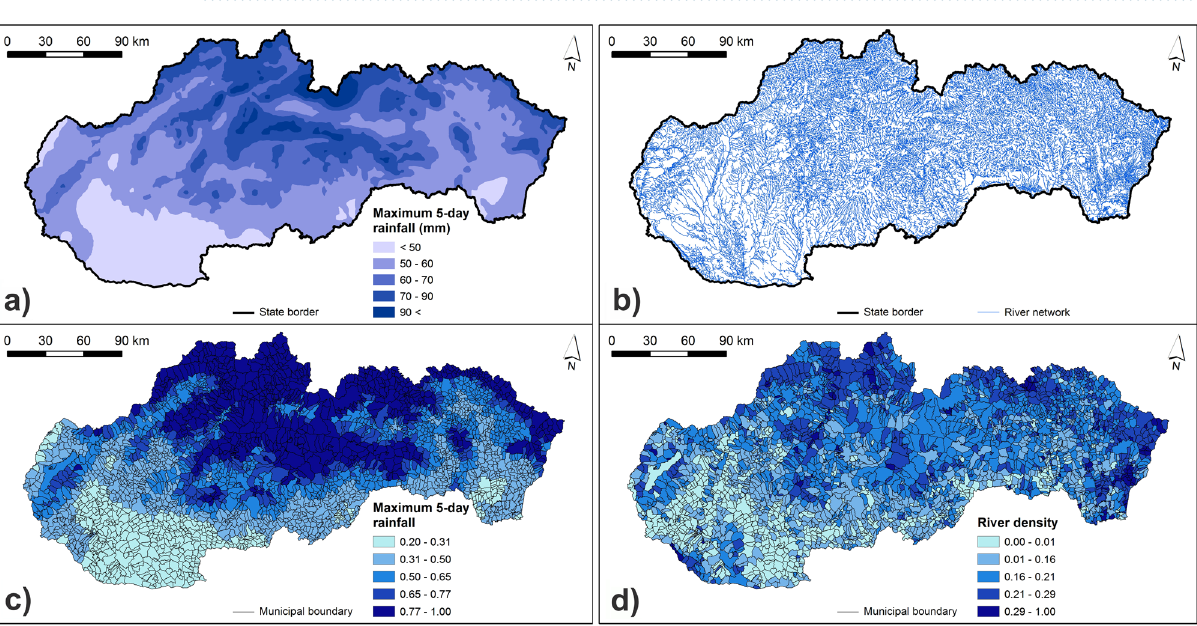
Figure 5. 5-day maximum rainfall and river density indicators: ( a ) original 5-day maximum rainfall values; ( b ) river network; ( c ) normalized 5-day maximum rainfall values; ( d ) normalized river density values. This figure was generated in ArcGIS 10.2.2